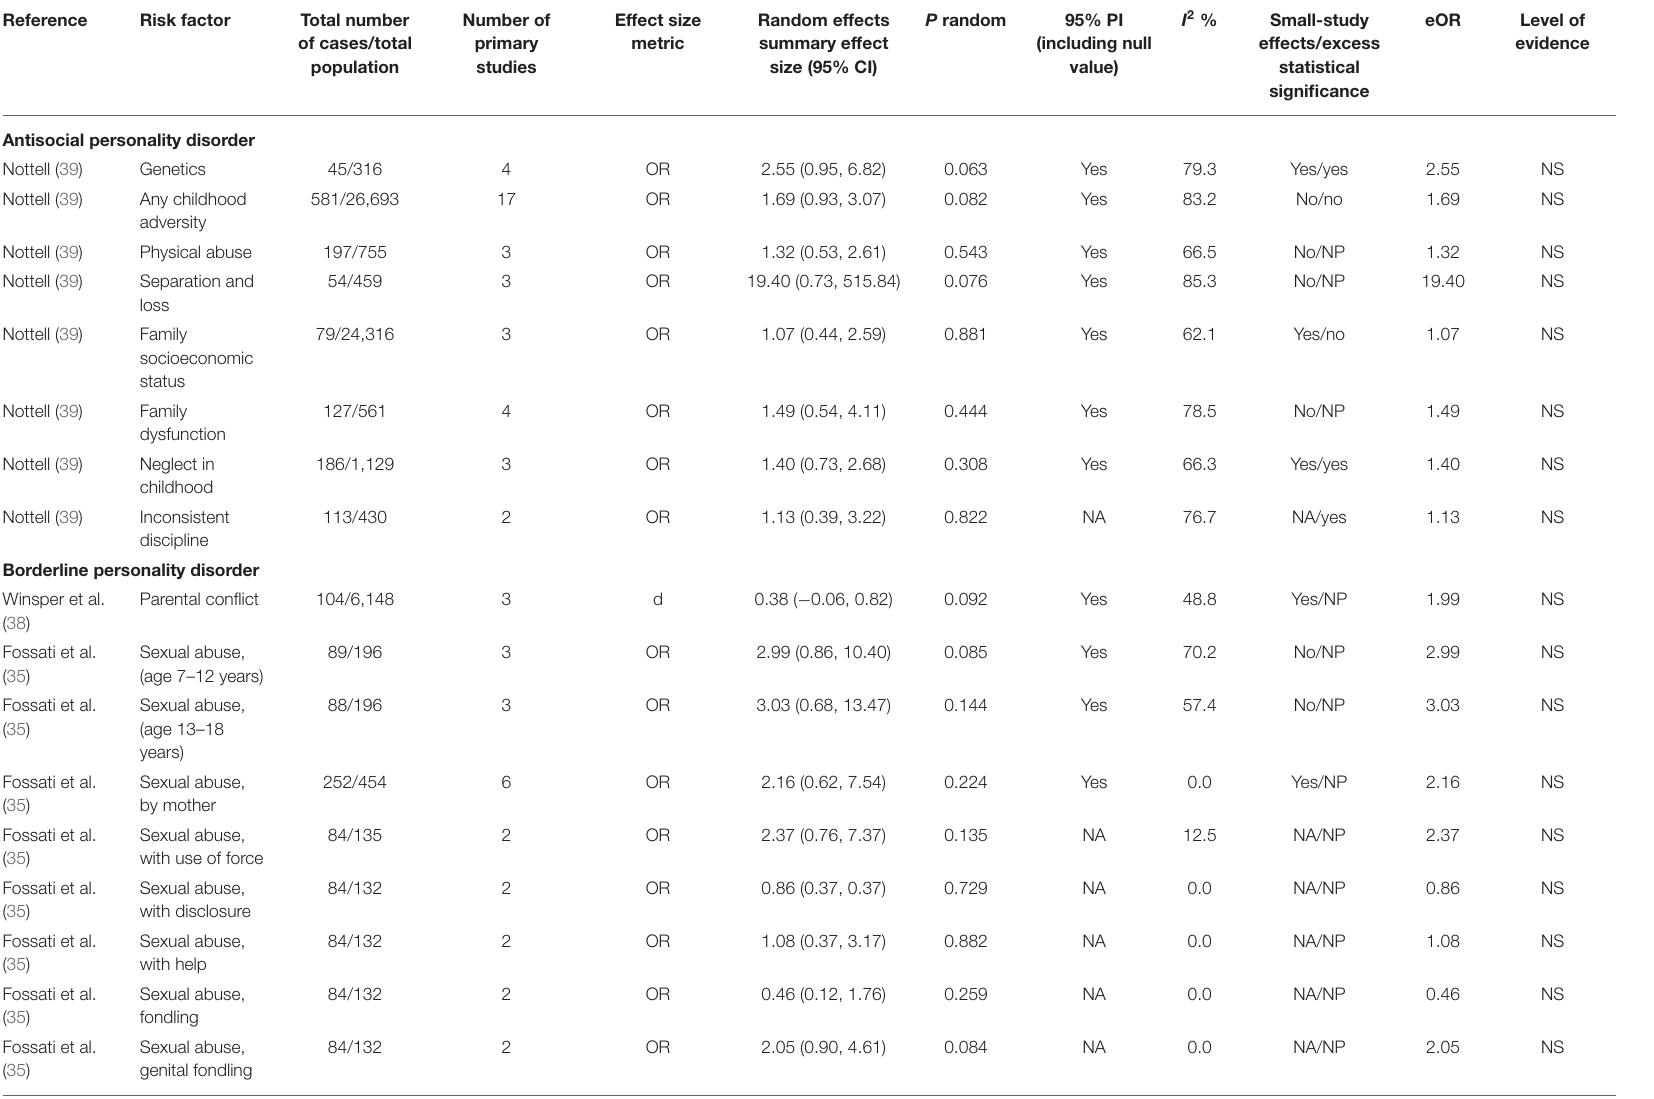
TABLE 4 | Non-significant ( p > 0.05) risk/protective factors for personality